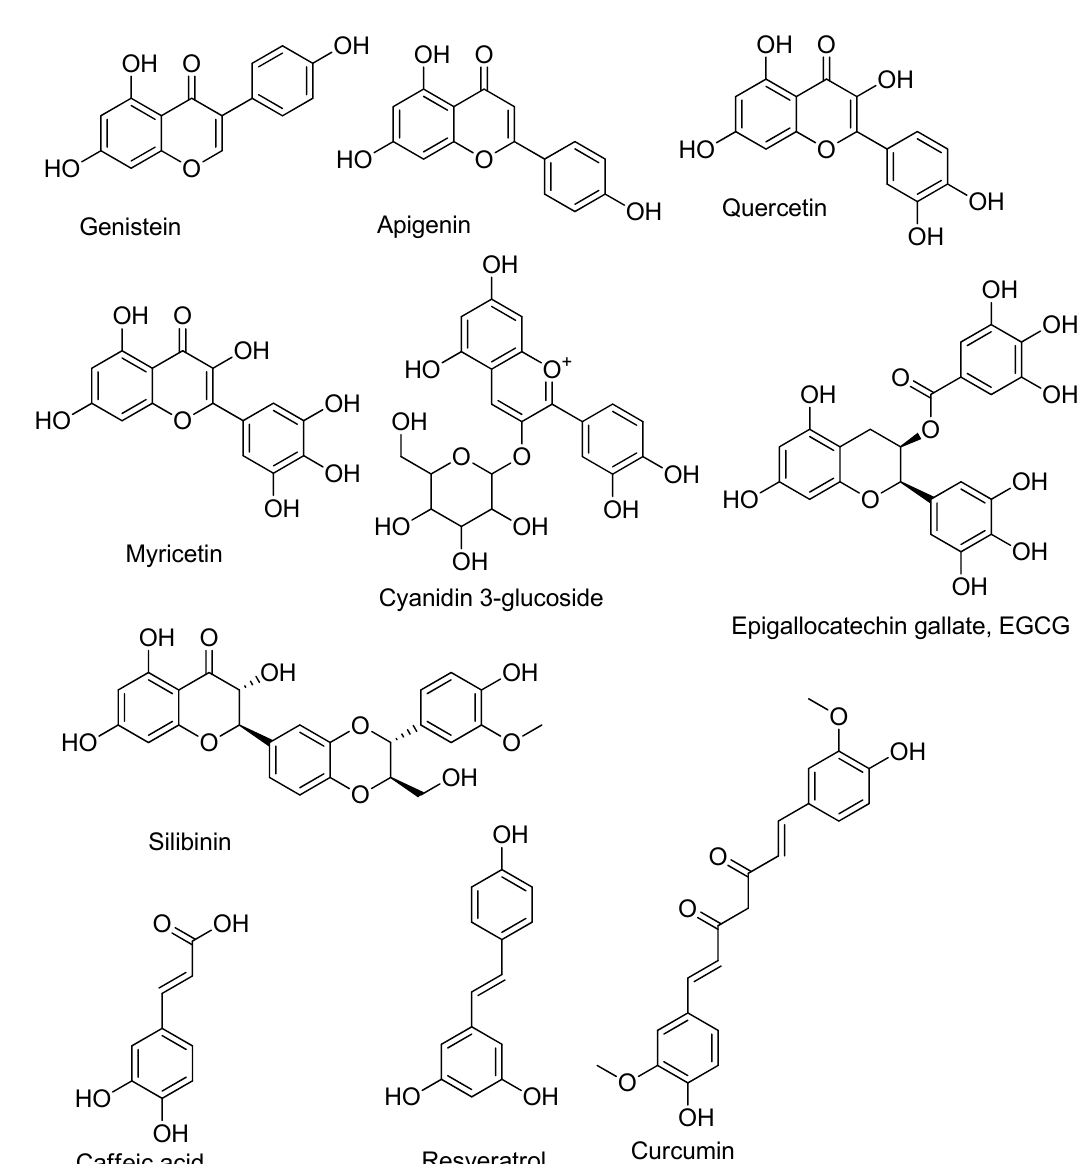
Figure 9. Main investigated phenols and polyphenols.